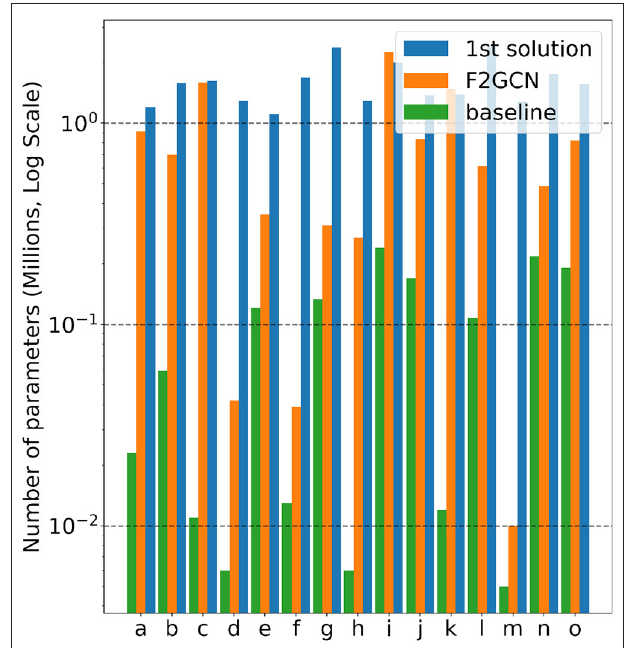
FIGURE 3 | Comparison of the number of parameters of baseline, 1st solution, and F 2 GCN (log